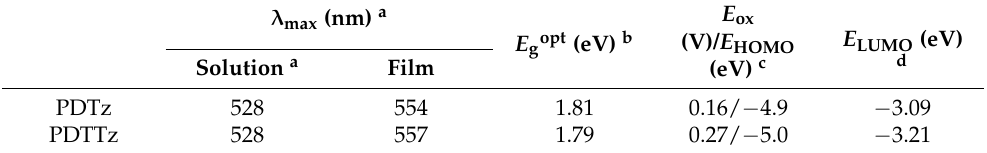
Figure 1. ( a ) Absorption spectra of PDTz and PDTTz in solution and film states. ( b ) Cyclic voltam- mogram of the polymer films. Absorption spectra of doped ( c ) PDTz and ( d ) PDTTz polymers depending on F4TCNQ concentration (0.5–2.0 mg mL − 1 ). Table 1. Optical and electrochemical properties of